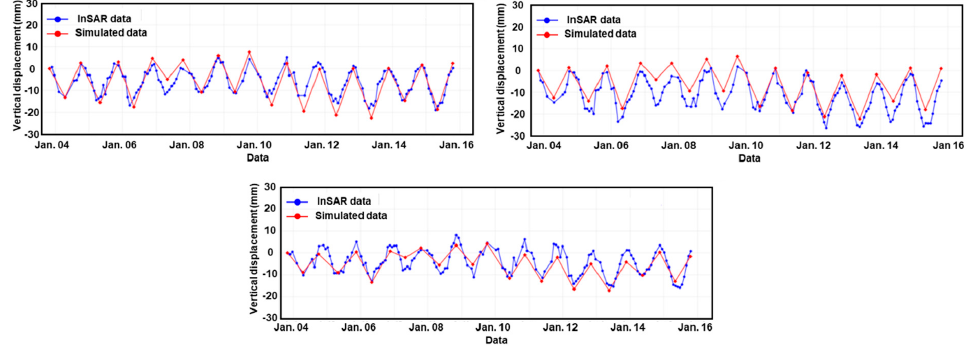
Figure 11. Comparison between simulated and measured vertical movements for three control points overlying the reservoir.